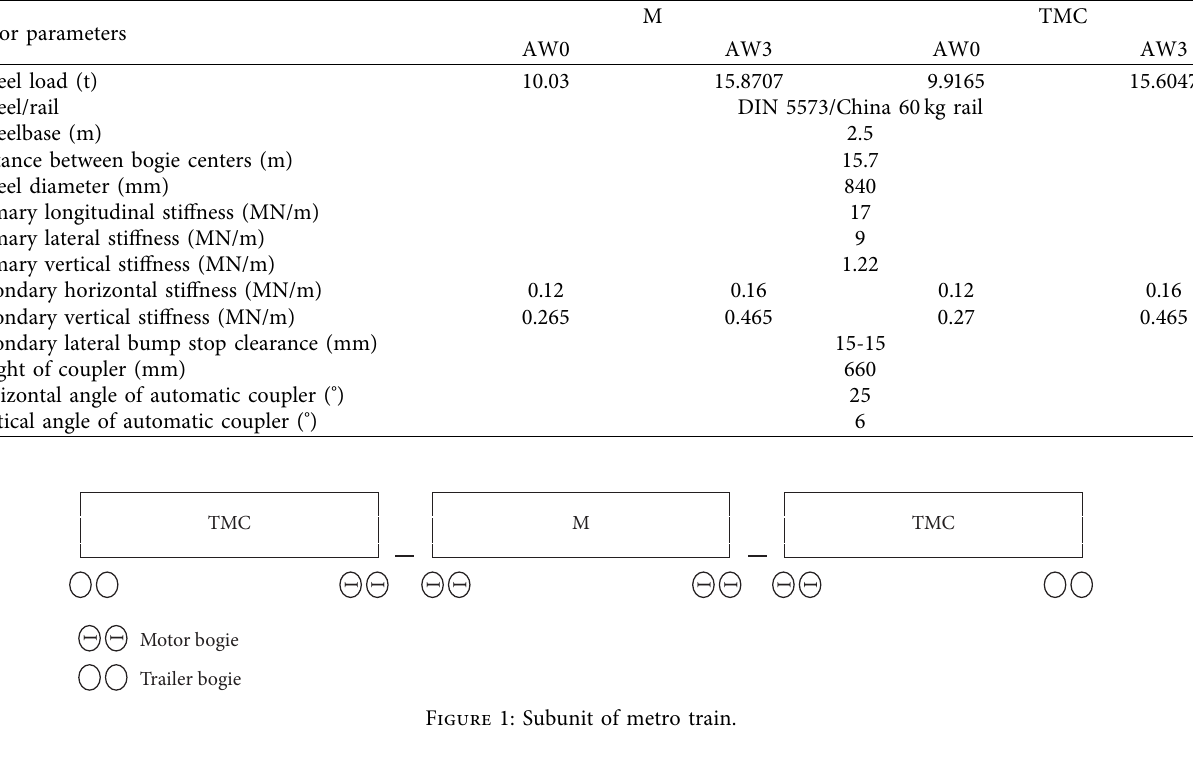
Figure 1: Subunit of metro train.